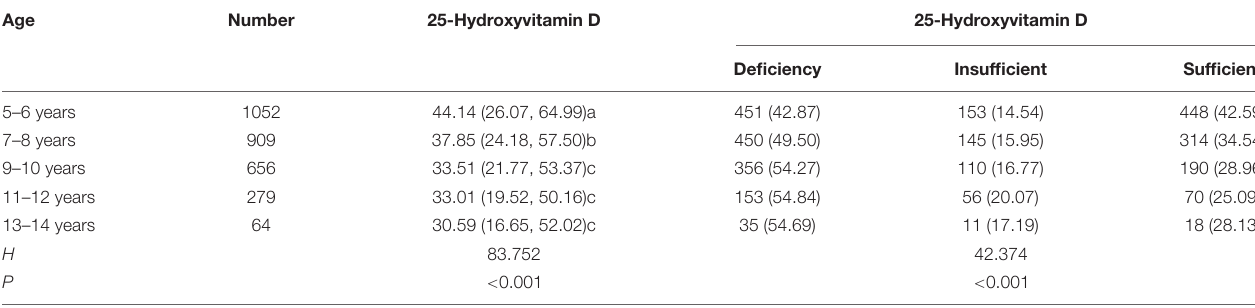
TABLE 4 | Comparison of vitamin D levels and degree of deficiency across different age groups in the TD group. Age Number 25-Hydroxyvitamin